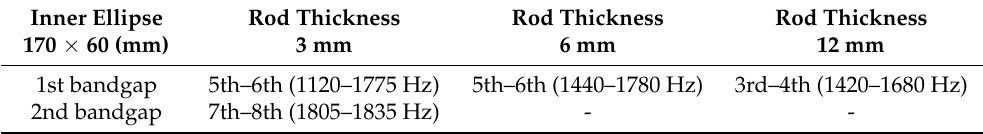
Table 5. Parametric investigation. Inner ellipse 170x80.